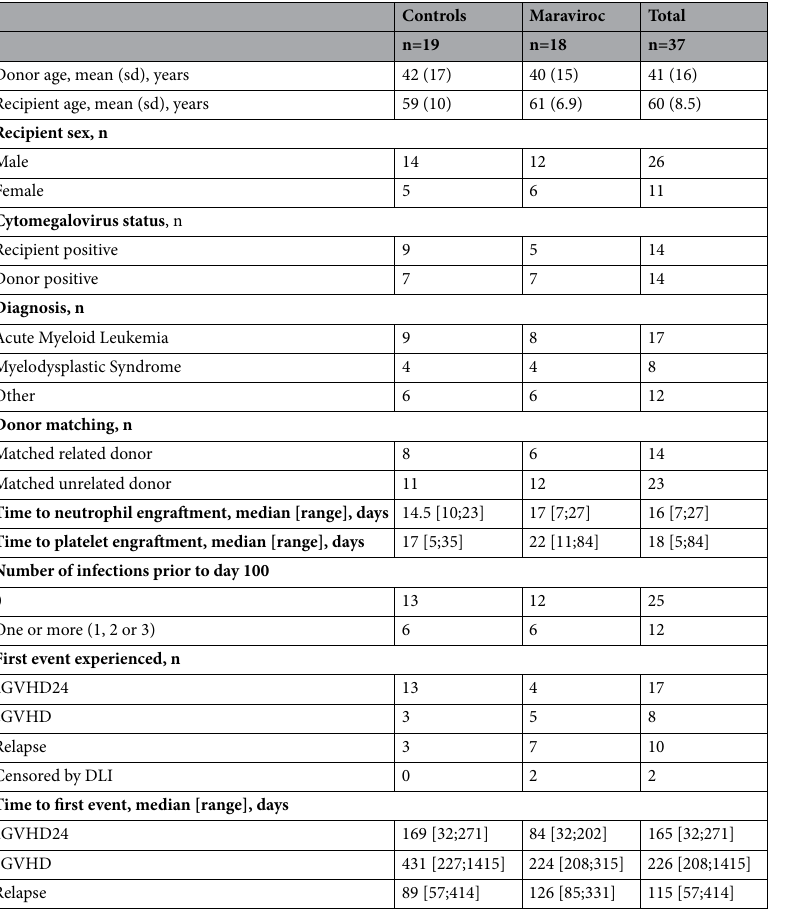
Table 1. Characteristics of the subset of patients used in the analysis. DLI Donor lymphocyte